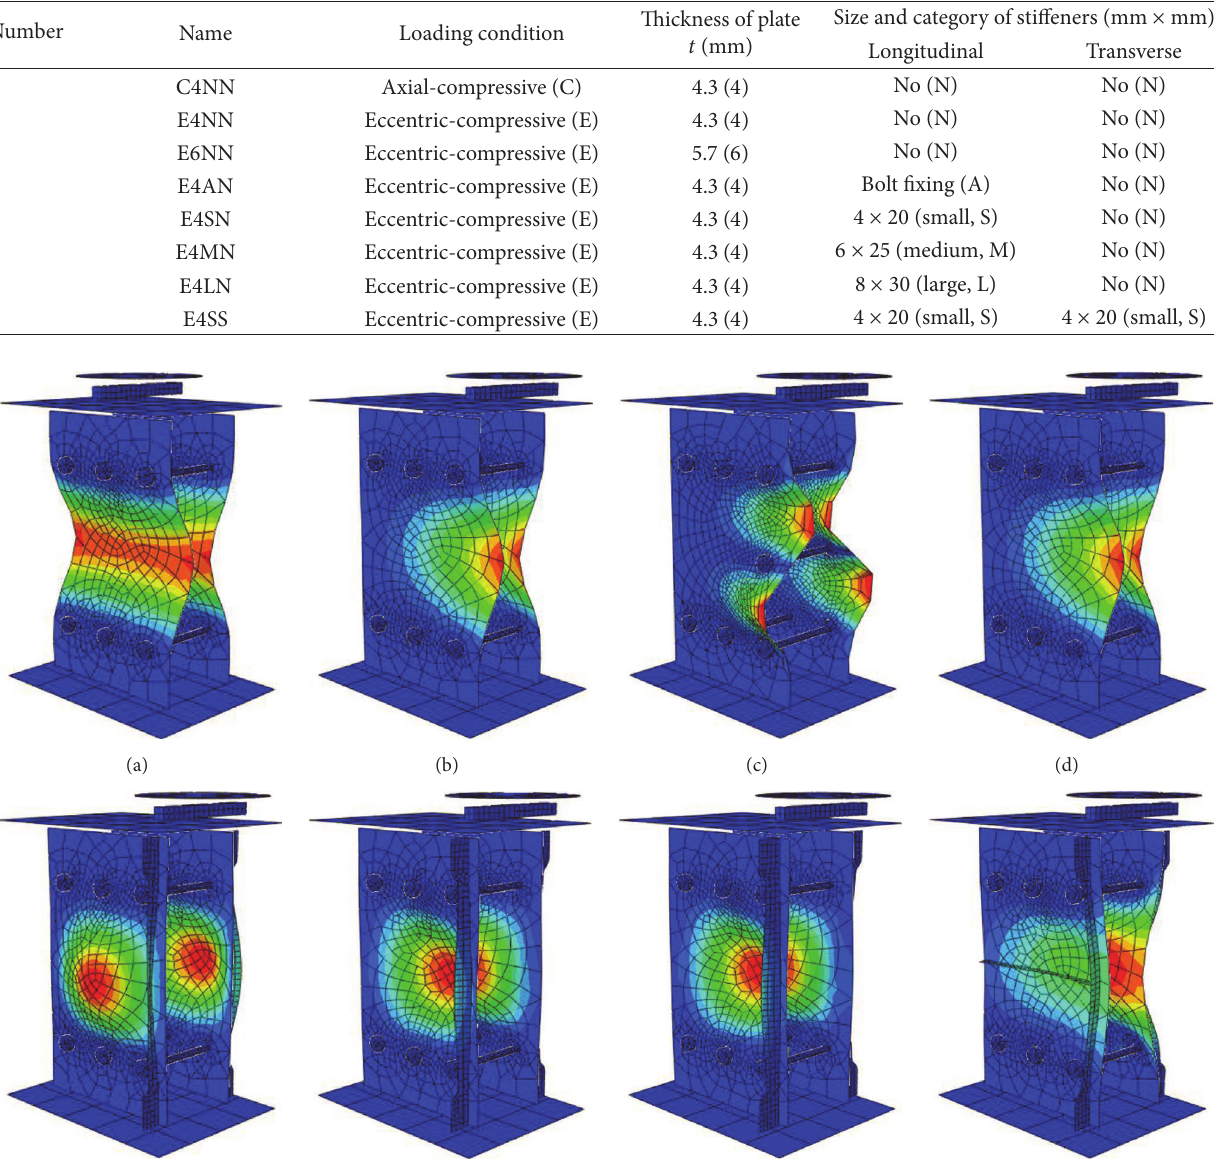
Table 3: The information of specimens.